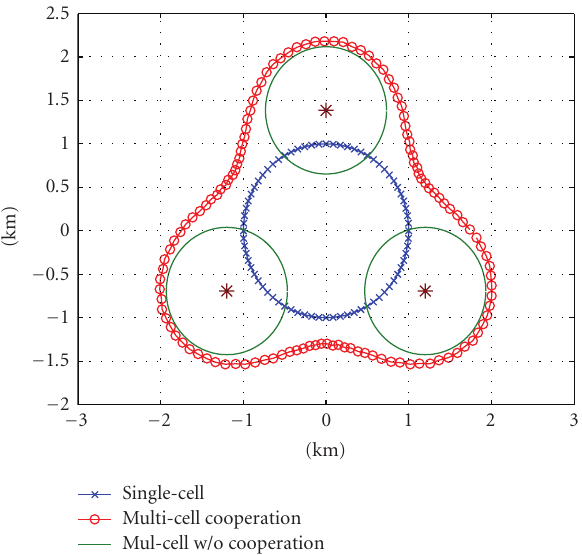
Figure 5: BC coverage area with q 0 =